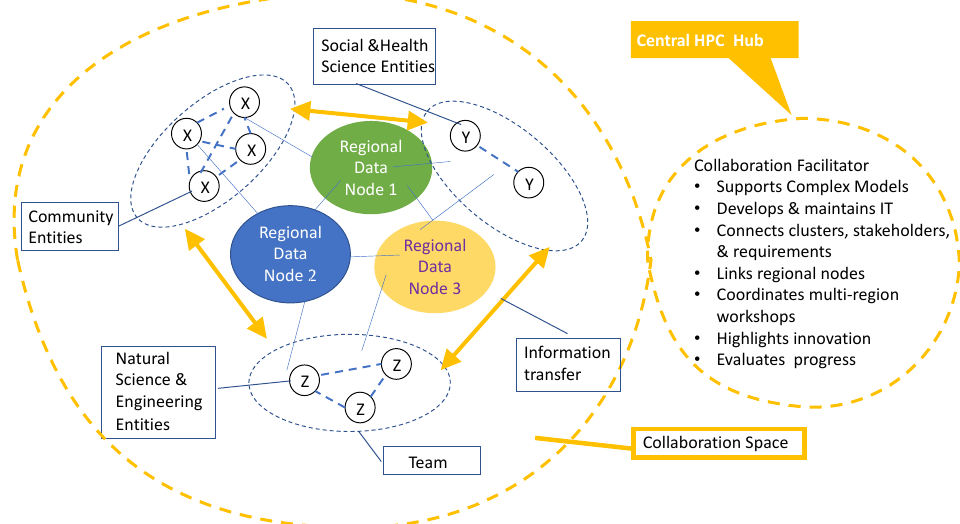
Figure 5. Concept of network integration involving regional nodes, a central HPC hub, talent clusters, and multiple disciplines with both regional and central (or super-regional) collaboration facilitation and management. Source: original figure.